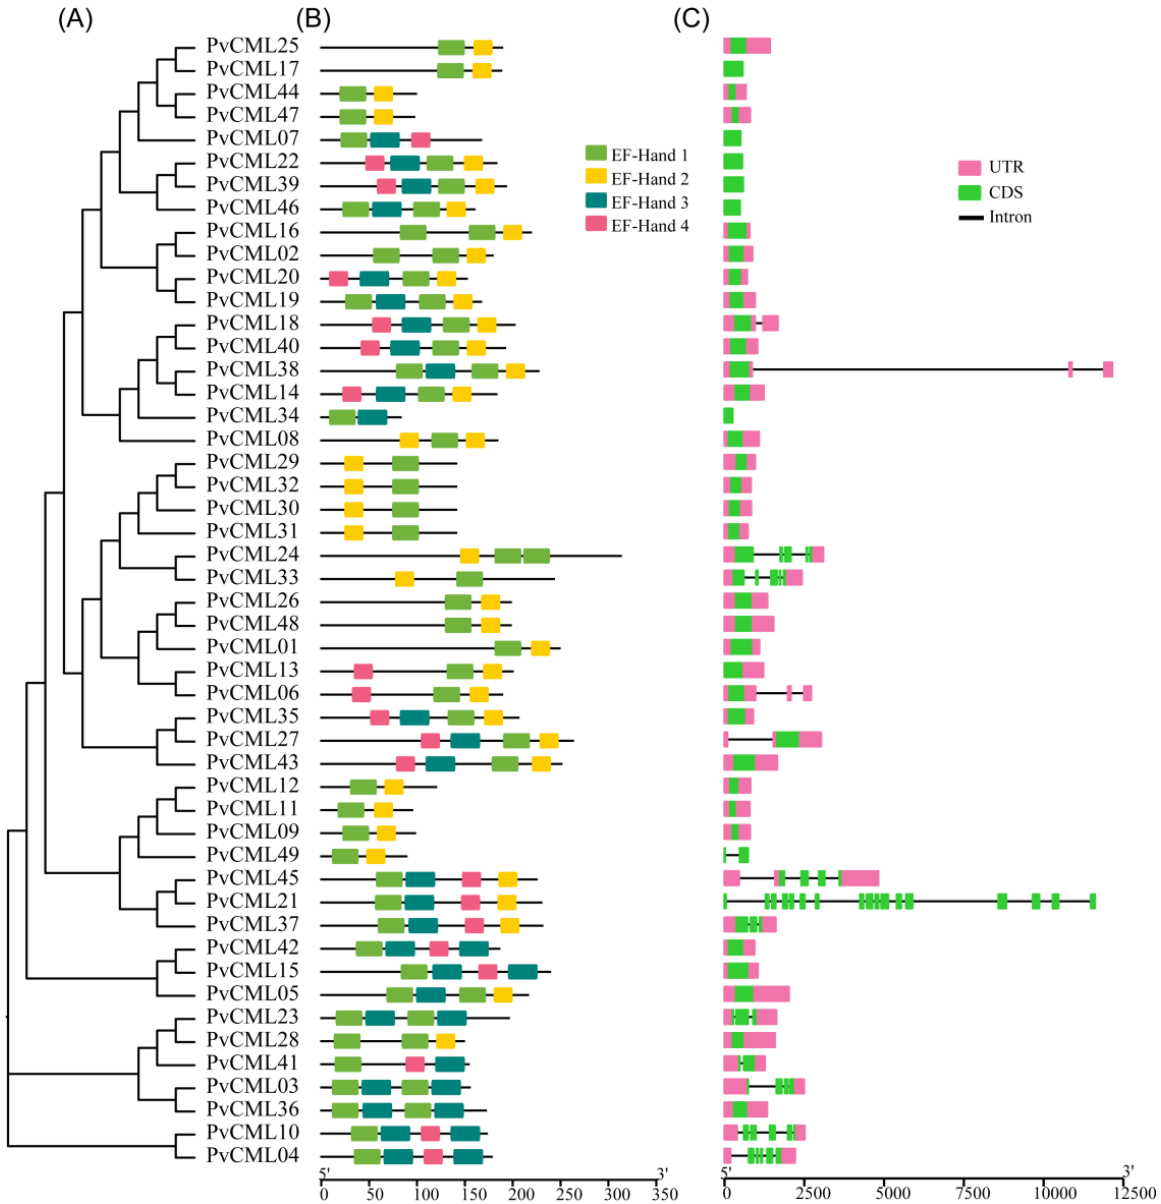
Figure 2. The conserved motif composition and gene structure of CMLs proteins in P. vaginatum . ( A ) phylogenetic relationship of PvCMLs. ( B ) The conserved EF-hand motifs of PvCMLs. ( C ) Gene structure of PvCMLs. Pink boxes represent untranslated regions (UTR), green boxes represent coding regions (CDS), and black lines represent introns.